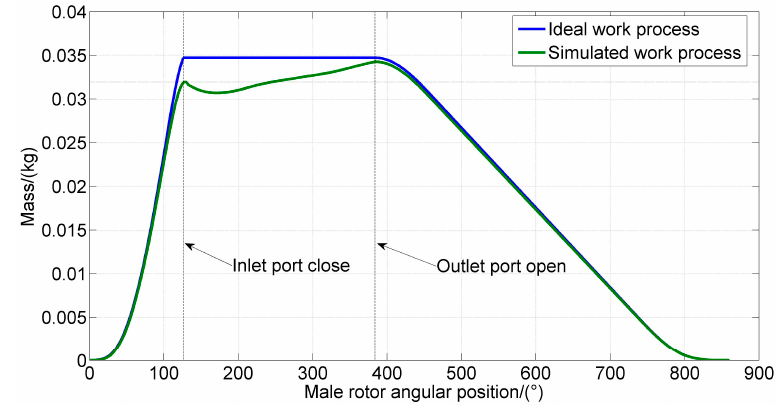
Figure 9. m ‐θ diagram of ideal and simulated work process ( P i = 1.3 MPa, T i = 192 °C, m t = 20 t/h, P o = 0.19 Mpa, n = 2400 rpm).